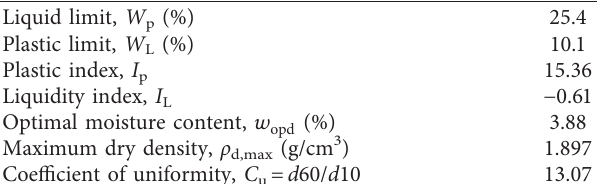
Table 1: List of basic physical property parameters of saline soil.